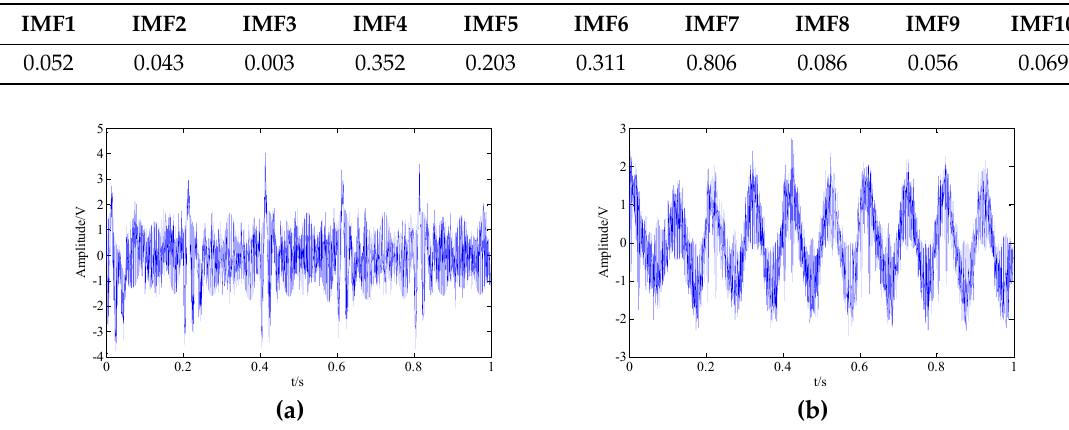
Figure 8. The result provided by empirical mode decomposition and independent component analysis (EMD-ICA): ( a ) shock signal in time-domain; and ( b ) harmonic signal in time-domain. Table 1. The correlation coefficient between each IMF and the simulation signal.